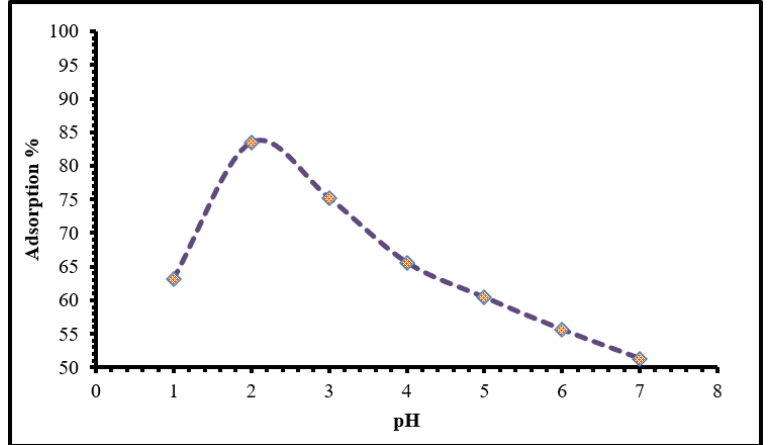
Figure 4. Influence of pH for the up taking of Cr(VI) using TIHP, (time 30 min., 20 mL sample, 0.1 g TIHP, T = 25 ± 1 °C and [Cr(VI)] = 250 mg/L).